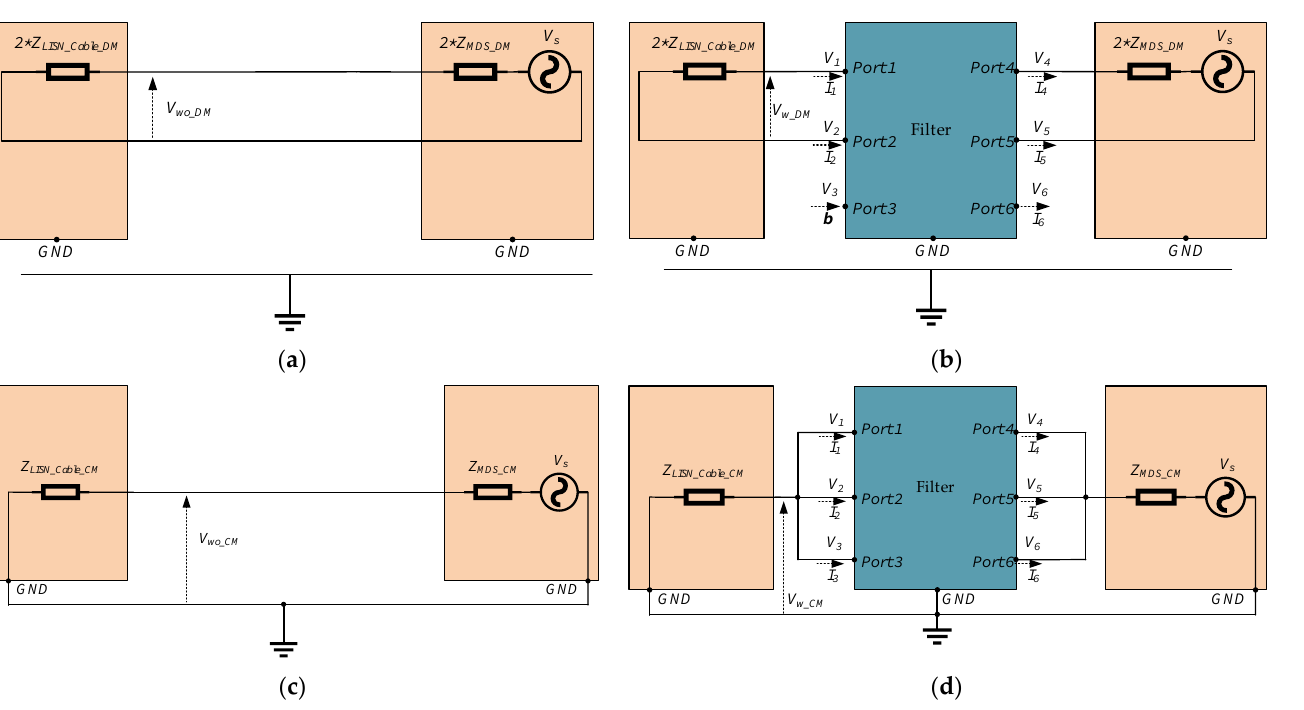
Figure 11. Setups for computing the in-circuit IL. Left and right panels show the ( a , b ) DM and ( c , d ) CM setups without and with the filter, respectively.